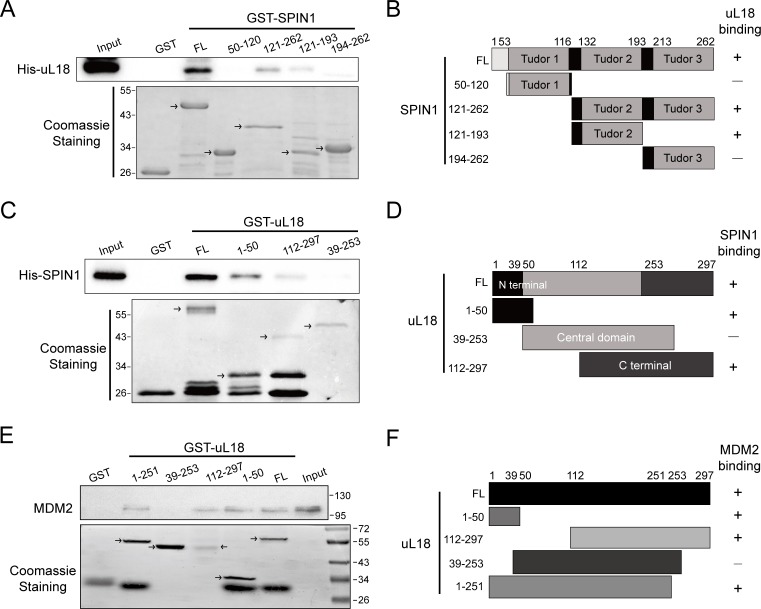
Mapping of domains responsible for uL18-SPIN1 and uL18-MDM2 binding.(A) uL18 interacts with the second Tudor like domain of SPIN1. Purified GST-tagged SPIN1 fragments, including aa 1-262(FL), aa 50–120, aa 121–262, aa 121–193, aa 194–262 and GST protein alone were incubated with purified His-uL18 protein for 3 hr at 4°C. Bound proteins were detected by WB analysis using anti-uL18 or coomassie staining. (B) A schematic diagram of uL18-binding regions on SPIN1 based on the result from (A). (C) SPIN1 interacts with both the N- and C-termini of uL18. Purified GST-tagged uL18 fragments, including aa1-297(FL), aa 1–50, aa 112–297, aa 39–253 or GST protein alone were rotated with purified His-SPIN1 protein for 1 hr at 4°C. Bound proteins were detected by WB analysis using anti-SPIN1 or coomassie staining. (D) A schematic diagram of SPIN1-binding regions on uL18 derived from the result from (C). (E) MDM2 interacts with both the N- and C-termini of uL18. Purified GST-tagged uL18 fragments, including aa1-297(FL), aa 1–50, aa 112–297, aa 39–253, aa 1–251 or GST protein alone were rotated with purified His-MDM2 protein for 4 hr at 4°C. Bound proteins were detected by WB analysis using anti-MDM2 (2A10) or coomassie staining. (F) A schematic diagram of uL18 binding regions on MDM2 based on the result from (E).